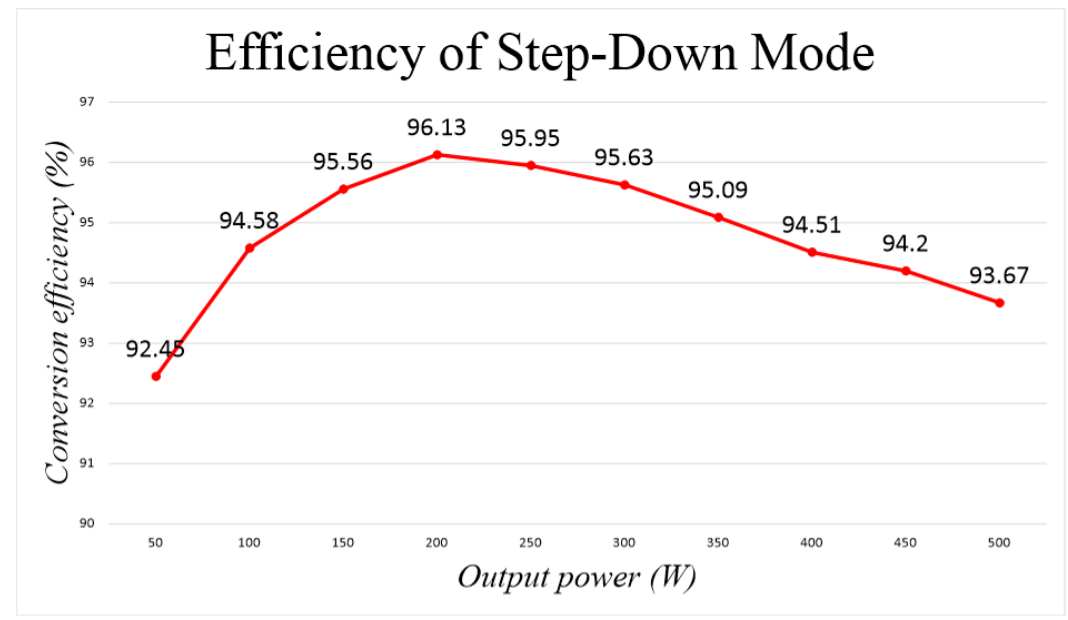
Figure 18. Energy conversion efficiency of the proposed topology in the step-down mode.